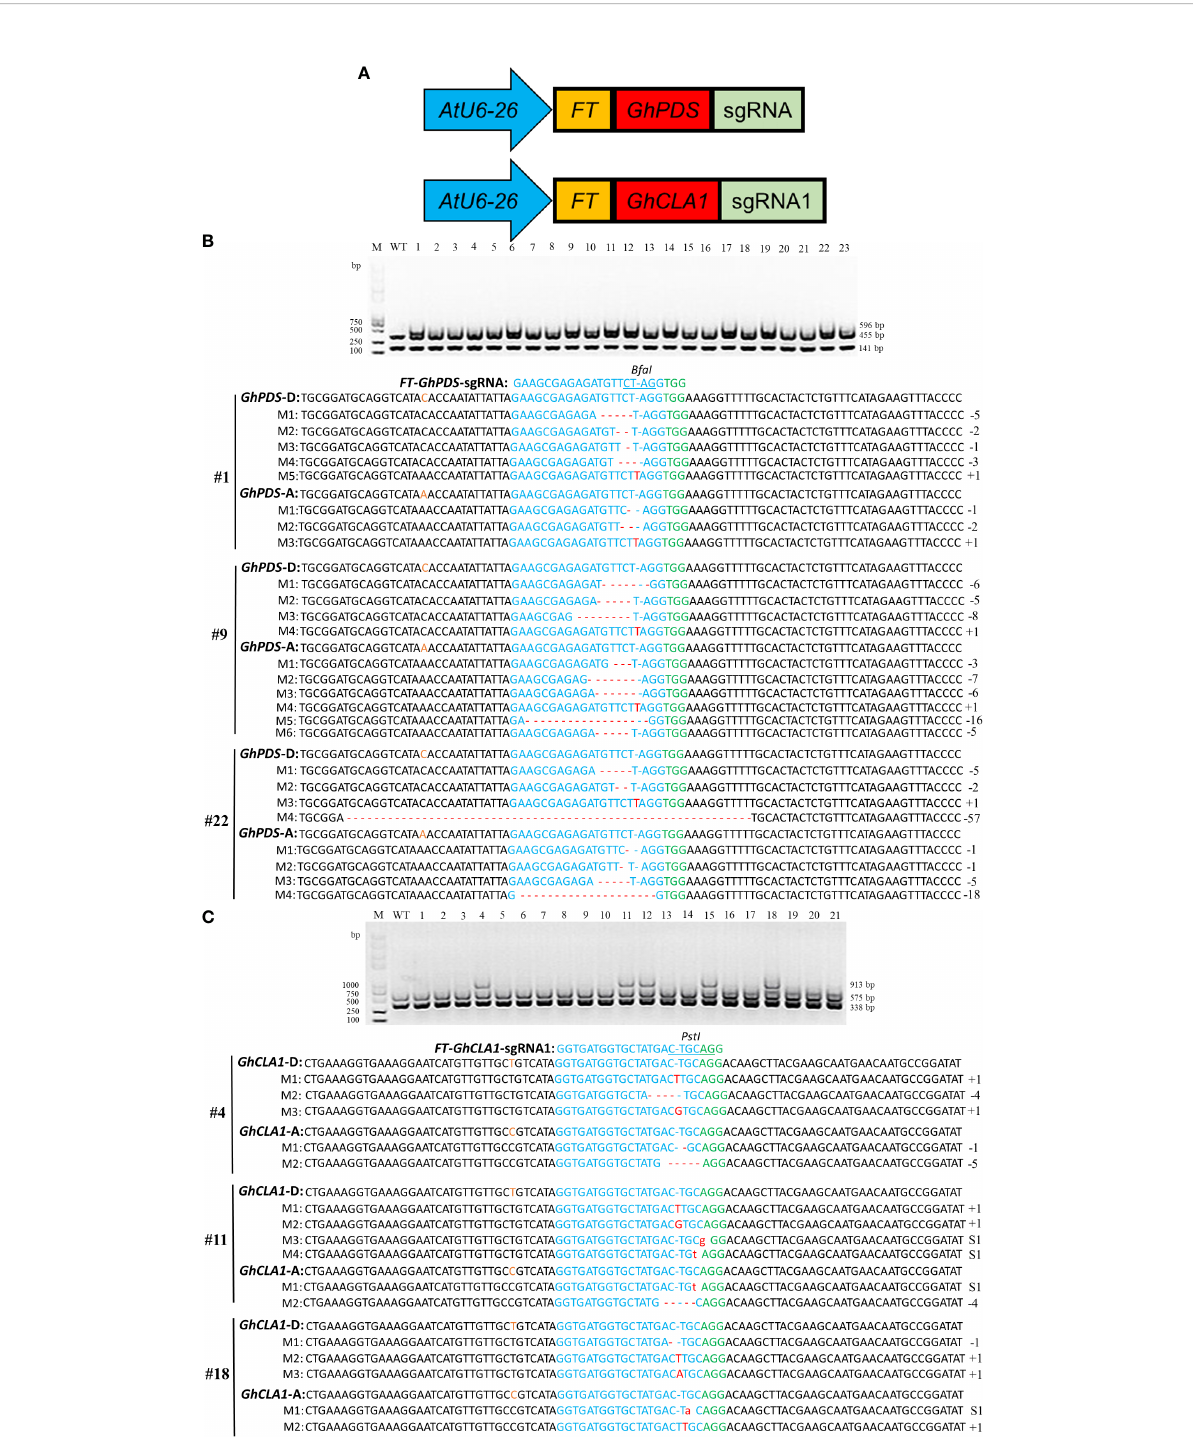
FIGURE 6 FT -sgRNA targeted mutagenesis of GhPDS and GhCLA1 in cotton. (A) Truncated FT RNA was fused to the 5 ’ end of GhPDS -sgRNA and GhCLA1 - sgRNA1. (B) Detection of FT - GhPDS -sgRNA targeted mutations. Wild-type served as a control, and 1-23 were plant numbers. The gel image shows the digested PCR products of the GhPDS gene with Bfa I, and the undigested PCR products lacking the Bfa I site (due to the presence of a mutation) were subsequently puri fi ed, cloned, and analyzed by sequencing. (C) Detection of FT - GhCLA1 -sgRNA1 targeted mutations. Wild-type served as a control, and 1-23 were plant numbers. The gel image shows the digested PCR products of the GhCLA1 gene with Pst I, and the undigested PCR products lacking the Pst I site (due to the presence of a mutation) were subsequently puri fi ed, cloned, and analyzed by sequencing. Green indicates the PAM sequence. The restriction site on the target sequence is underlined in blue. M indicates the mutation sequence. Insertions are denoted with red capital letters. Deletions are shown as red dashes. Substitutions are denoted with red lowercase